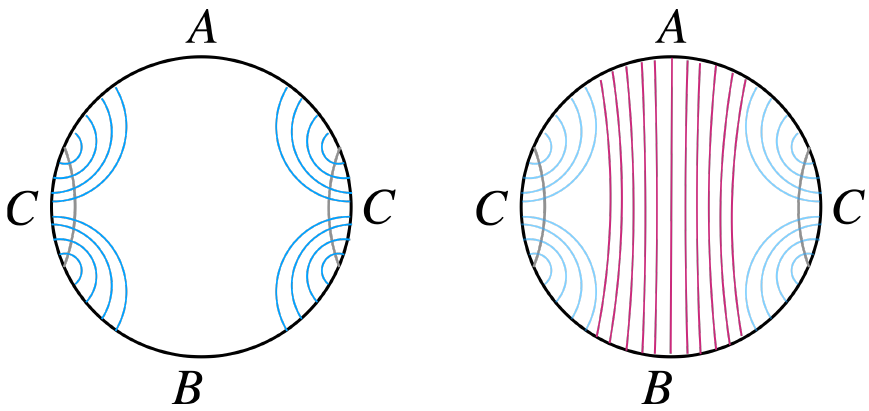
Figure 41 . The left figure is the first step involving a maximal bit thread configuration flowing from C to A ∪ B . The gray lines represent the Ryu-Takayanagi surface. In the second step (right figure), the old flow w (blue lines) remains and a new flow v (magenta lines) must be constructed and optimized. It is this flow that computes the logarithmic